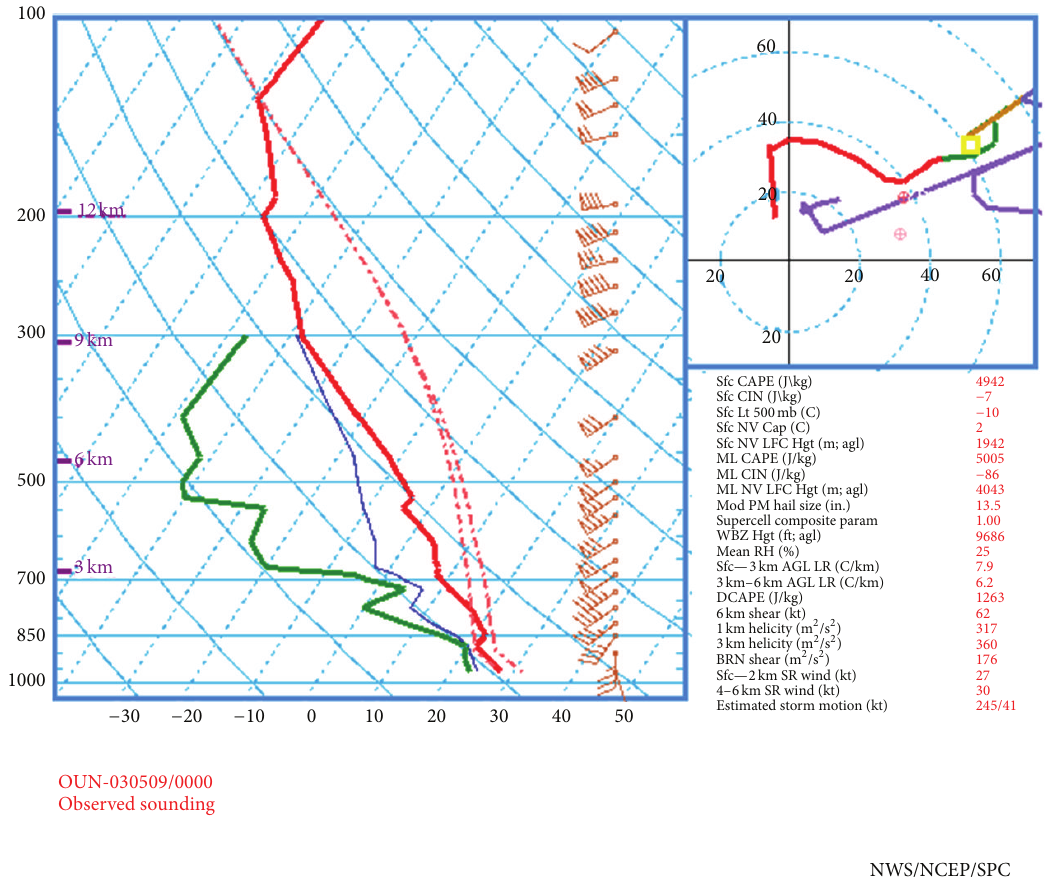
Figure 3: 0000 UTC 9 May 2003 sounding from Norman, Oklahoma (image from http://www.spc.noaa.gov/).